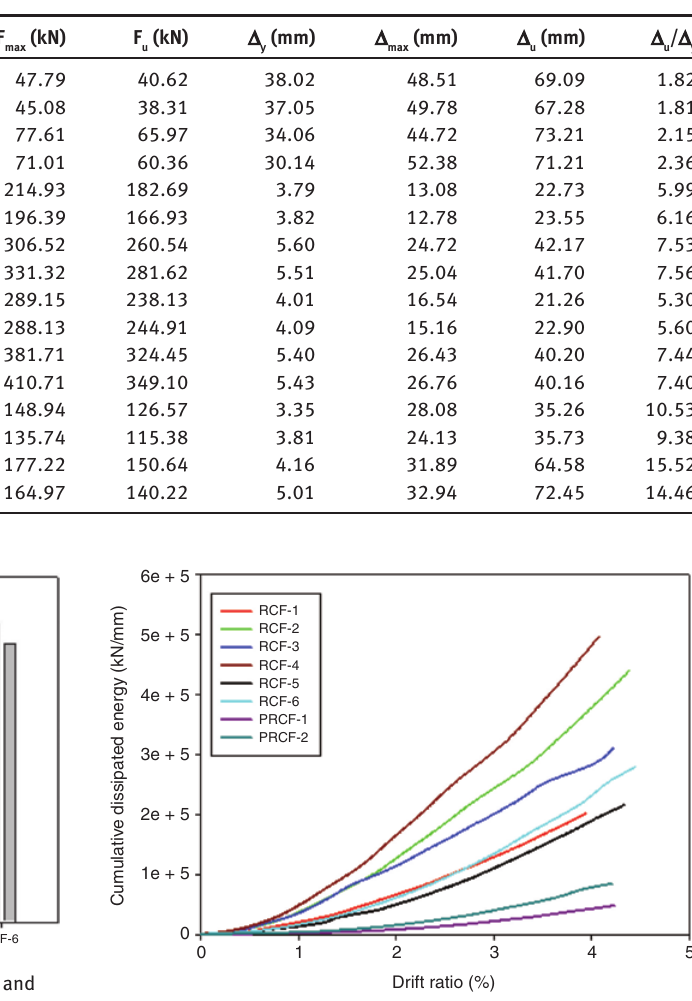
Figure 12: Cumulatively dissipated energy of the test